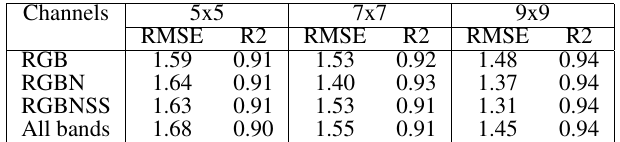
Table 4. Accuracy assessment on different CNN architectures. Models